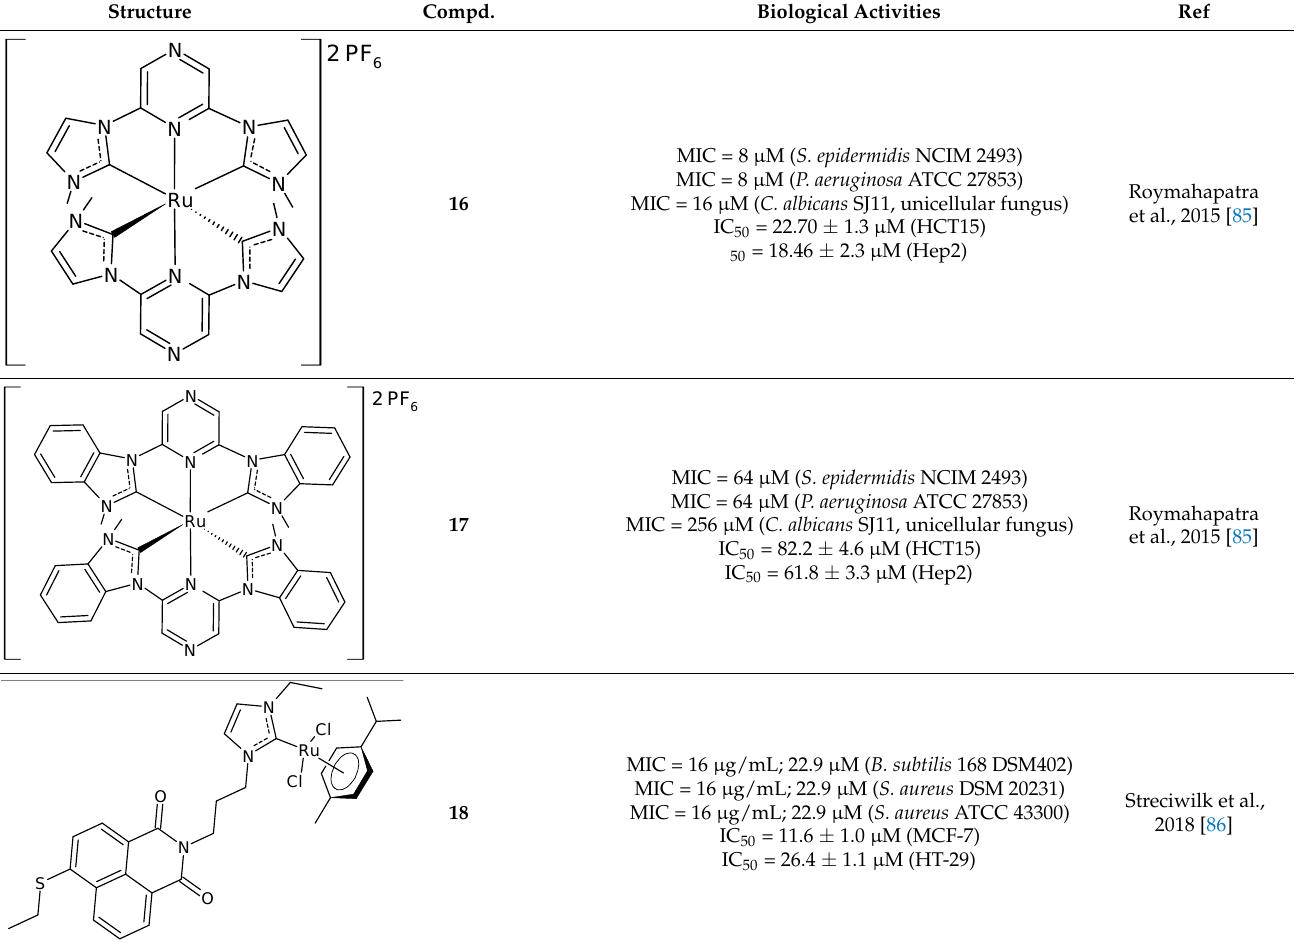
Table 2. Antimicrobial and other activities (antiproliferative, antioxidant and anticholinesterase) of Ru(II)-NHC complexes.